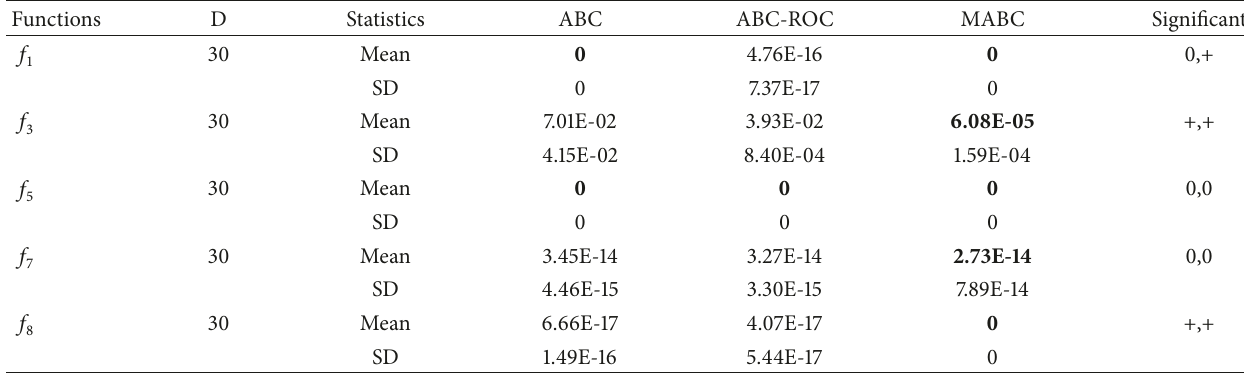
Table 3: Performance comparison of ABC, ABC-ROC, and MABC